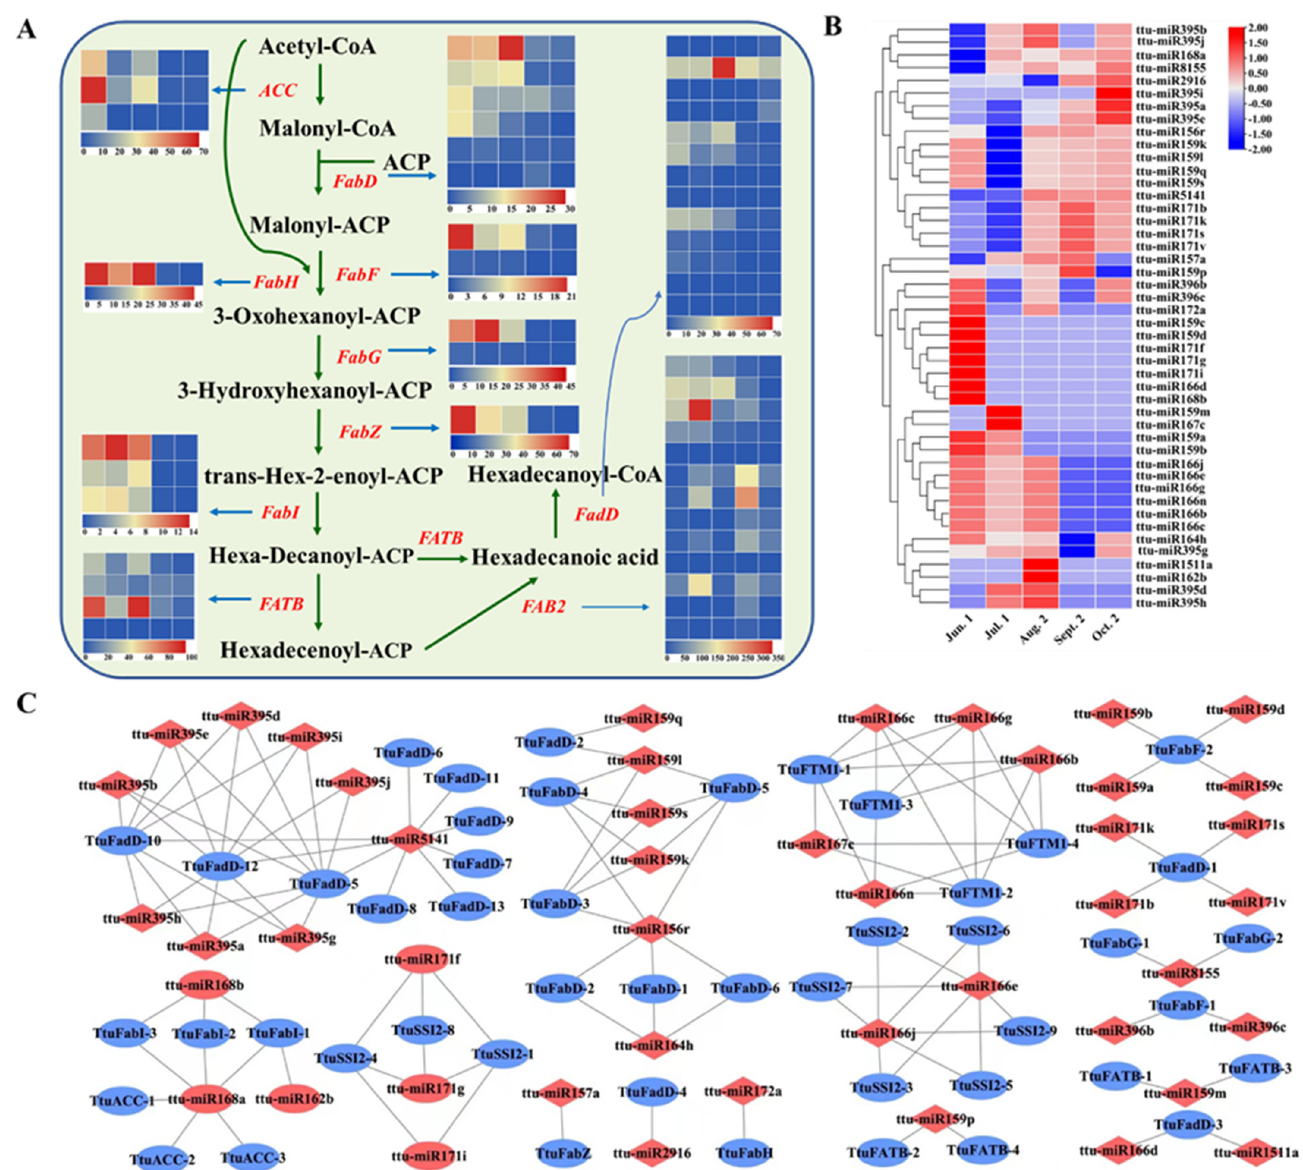
Figure 5. Enrichment analysis of candidate targets in fatty acid biosynthesis pathway. ( A ) Represents targets functions of miRNA involved in fatty acid biosynthesis, Heat maps of gene expression levels (FPKM) at five different seed maturation stages. ( B ) Heat map of expressed miRNAs involved in fatty acid biosynthesis. ( C ) Represents the view of miRNA-mRNA network involved in fatty acid. The red color represents miRNA and the blue color represents targets.